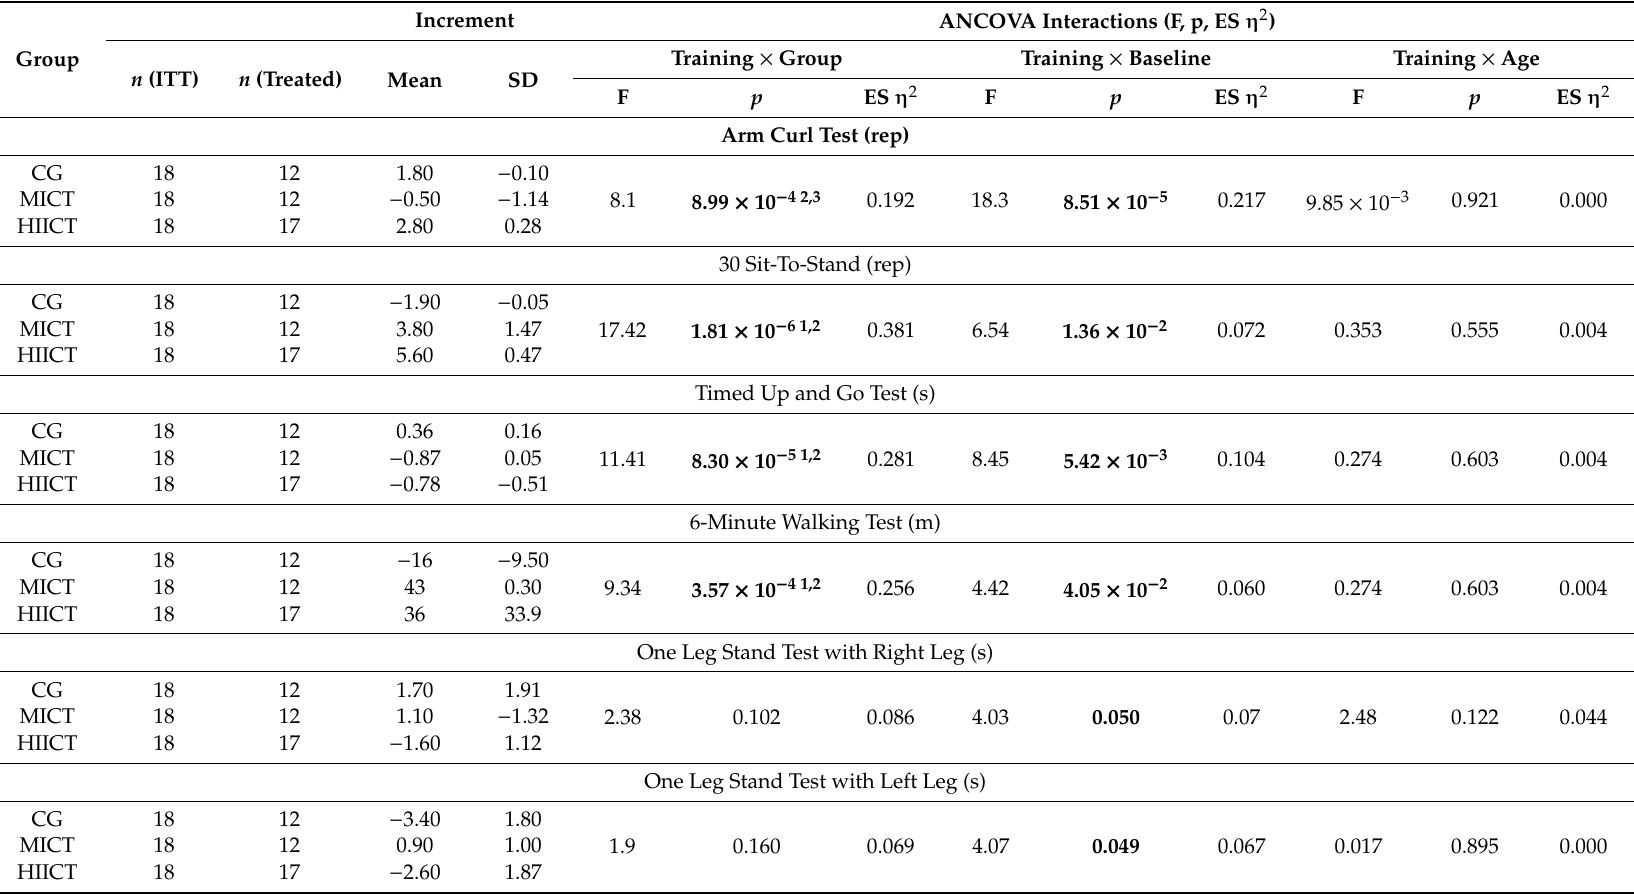
Table 4. ANCOVA adjustments for the primary outcomes on HIICT, MICT and